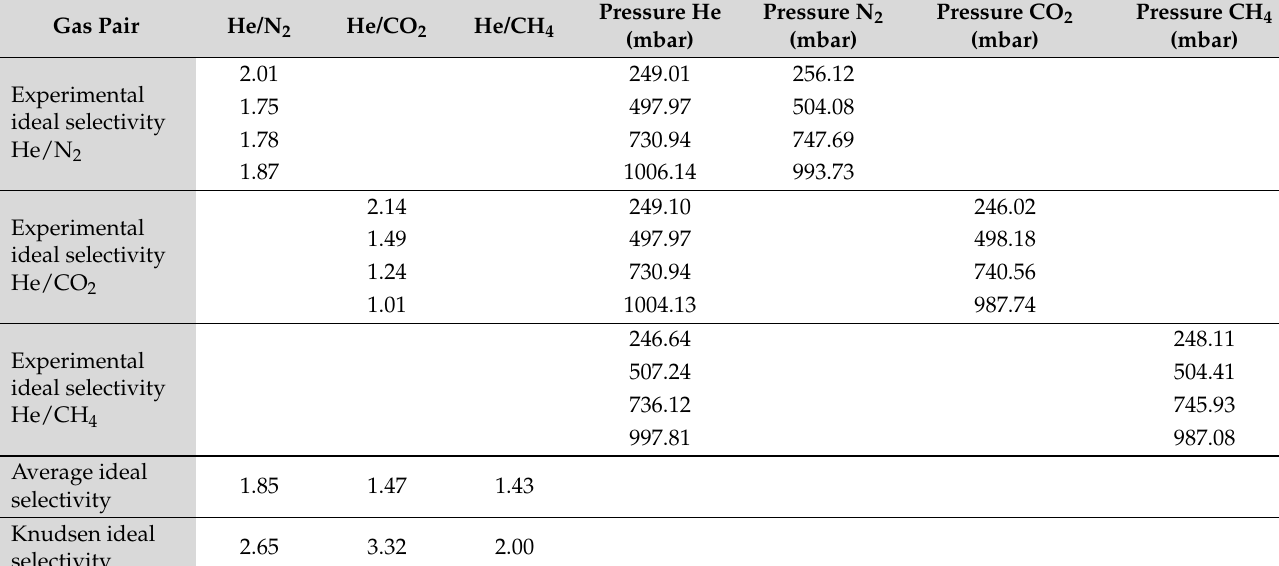
Table 5. Mean ideal selectivity values for the pairs of single gases H 2 , N 2 , and CO 2 with helium, for the CM5 membrane, over the entire experimental pressure range at 100 ◦ C, in comparison to the corresponding Knudsen ideal